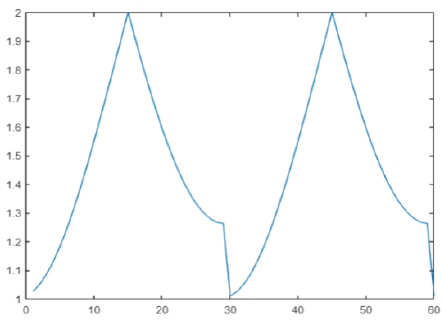
Figure 2. Cyclic learning rate.